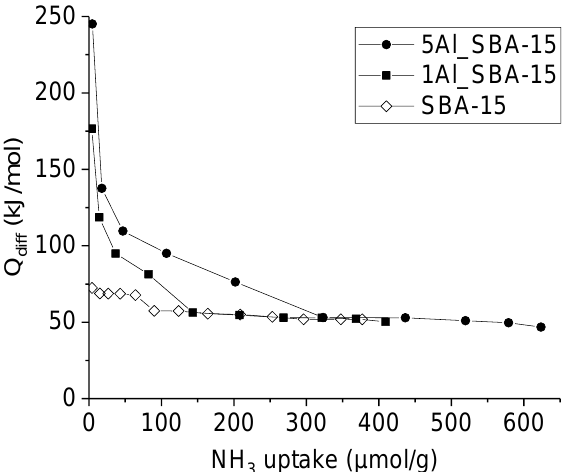
Figure 1. 27 Al MAS NMR spectra of 1Al_SBA-15 ( a ) and 5Al_SBA-15 ( b ).